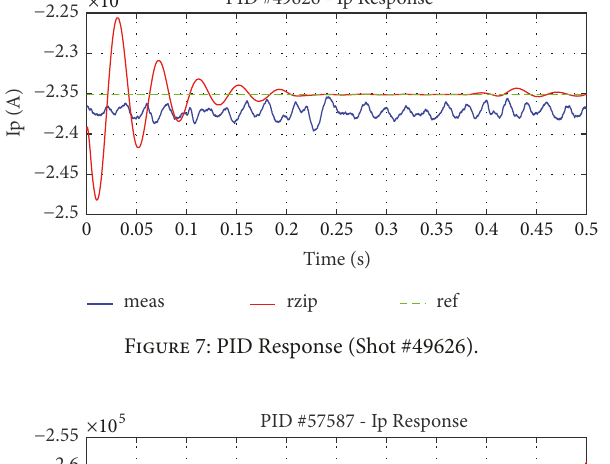
Figure 10: Sliding mode response (Shot #57587).